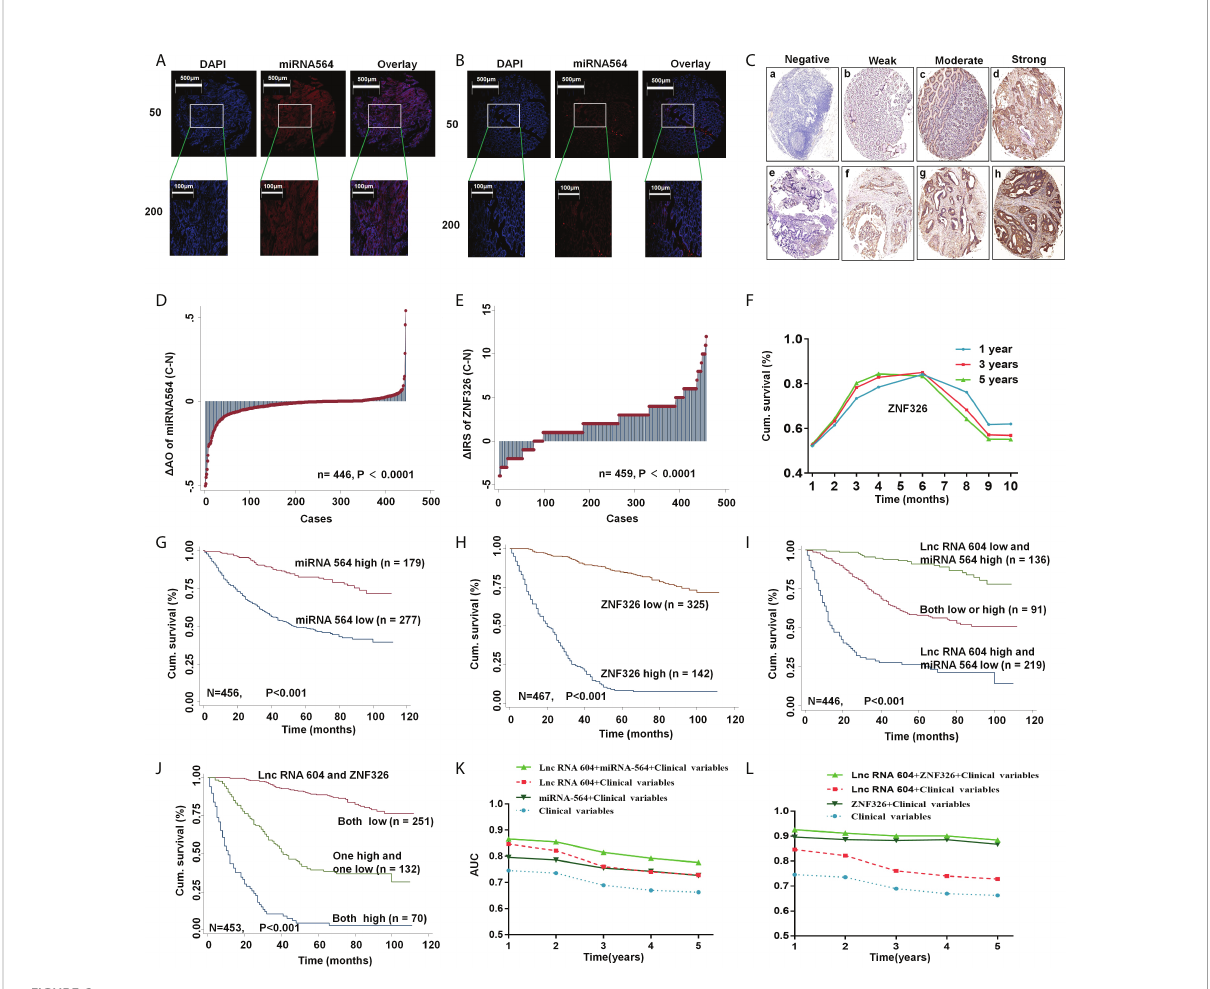
FIGURE 6 LncRNA 604 with its regulatory molecules predicted the prognosis of CRC. (A, B) The typical pictures of miRNA 564 was detected by FISH (A)cancer; (B) normal tissue). (C) The typical pictures of ZNF326 was detected by IHC. (D, E) Molecular expression was analyzed in tumor and normal tissues ( D ) miRNA 564; (E) ZNF326). (F) The cutoff value of ZNF326 was calculated by ROC analysis. (G, H) High miRNA 564 or low ZNF326 expression had a better OS in CRC patients by Kaplan-Meier survival analysis. [ (G) miRNA 564; (H) ZNF326]. (I, J) LncRNA 604 combined with its regulatory molecules had the best survival prognosis by Kaplan-Meier survival analysis [ (I) lncRNA 604 and miRNA 564; (J) lncRNA 604 and ZNF326]. (K, L) ROC analysis indicated lncRNA 604 combined with miRNA 564 or ZNF326 had a synergistic effect on prognosis of CRC patient [ (K) lncRNA 604 and miRNA 564; (L) lncRNA 604 and